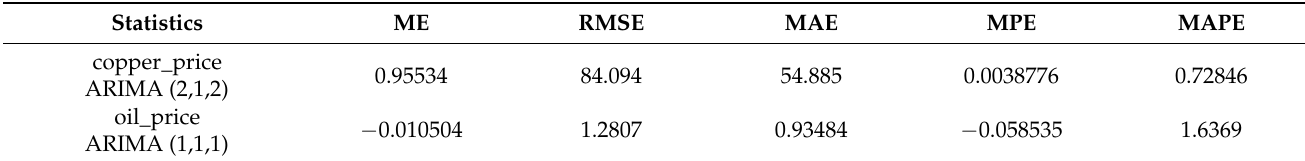
Table A2. Statistic of time-series.